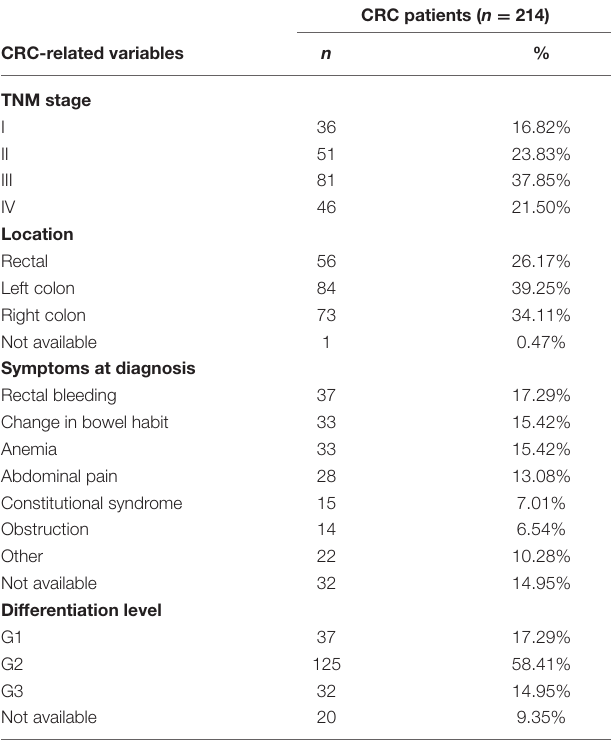
TABLE 1 | Clinical characteristics of CRC patients.